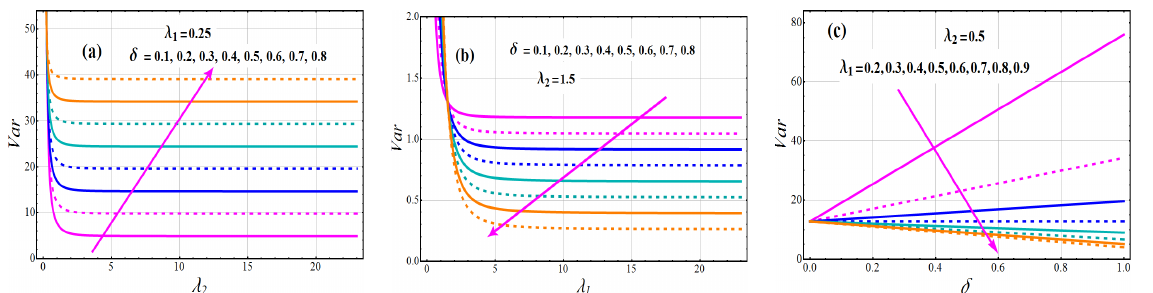
Fig. 4. Variations of Variance of TC-MAM.